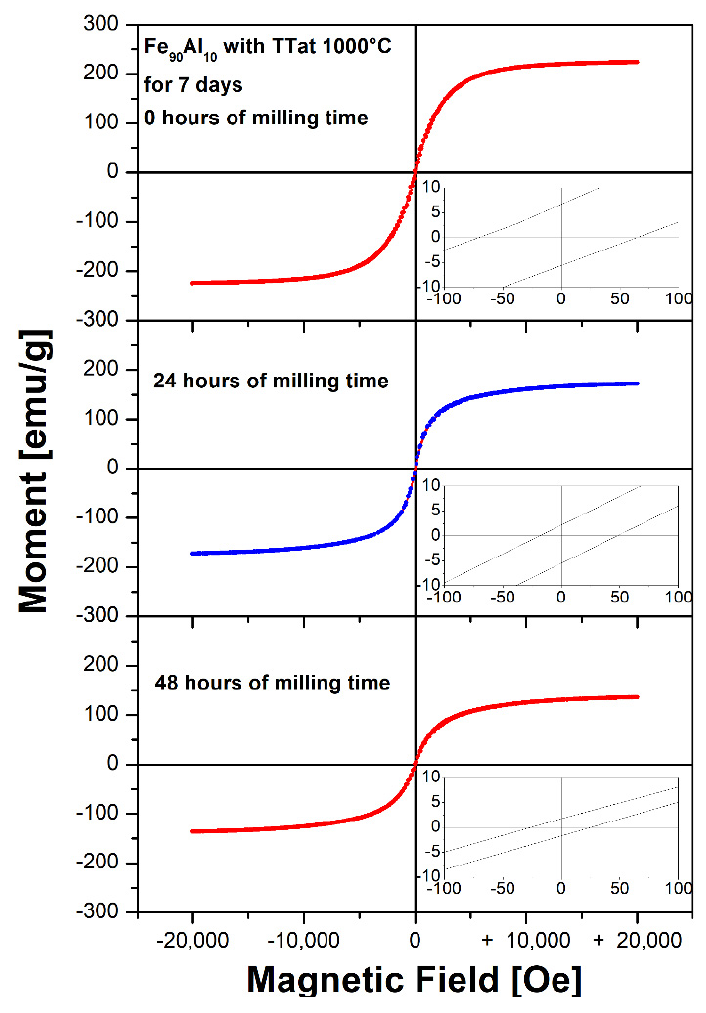
Figure 5. Hysteresis loops Fe 90 Al 10 system with thermal treatment at 1000 ◦ C for 7 days and mechanically alloyed for 24 and 48 h, respectively. Table 3. Extrinsic magnetic properties of the Fe 90 Al 10 system with thermal treatment at 1000 ◦ C for 7 days and milled for 24 and 48 h with oleic acid as a surfactant (the column with (Hc) corresponds to the coercive field; the column with (Mr) corresponds to the remanent magnetization; and the column with (Ms) corresponds to the saturation